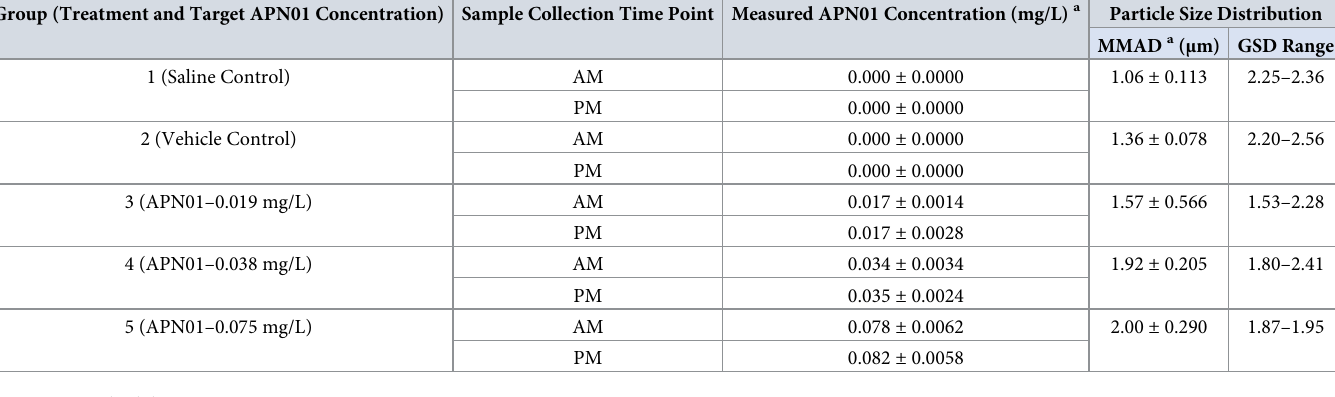
Table 2. Characterization of APN01 aerosols. Samples were collected at morning (AM) and afternoon (PM) exposures and characterized for APN01 concentrations to enable dose calculation and assess particle sizes to confirm respirability. GSD, geometric standard deviation; MMAD, median mass aerodynamic